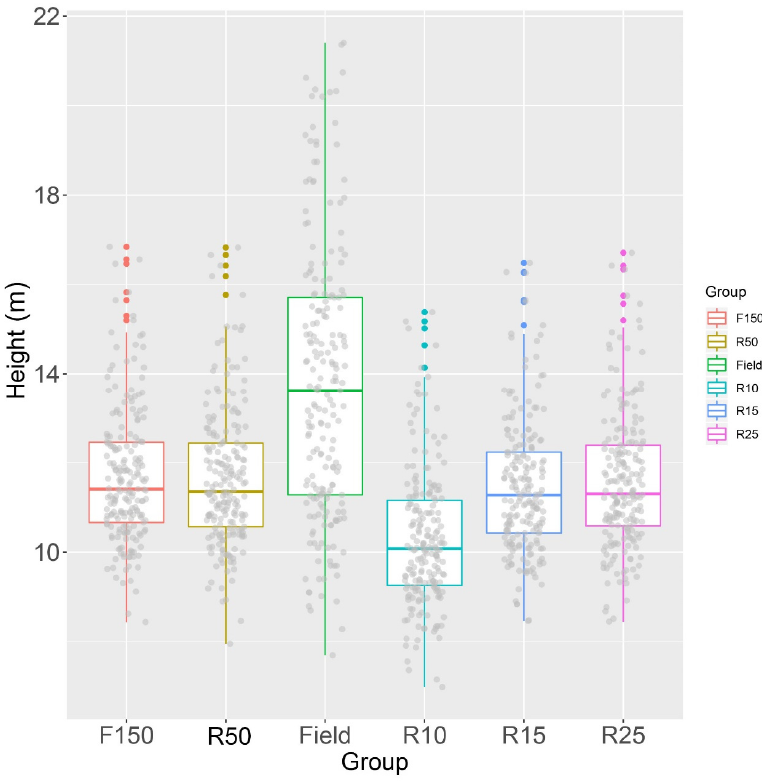
Figure 5. Box diagram of D. pierrei height obtained in different ways. Table 3. Extraction accuracy of D. pierrei height under different point cloud densities.